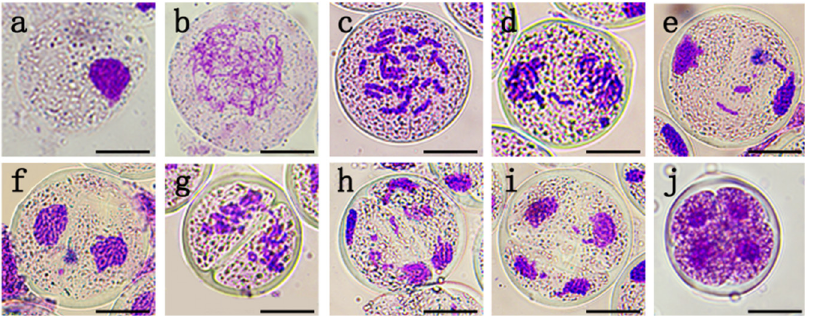
Table 1. Correlation between bud/anther lengths and meiotic stage in PMCs of ‘Black Beauty’.